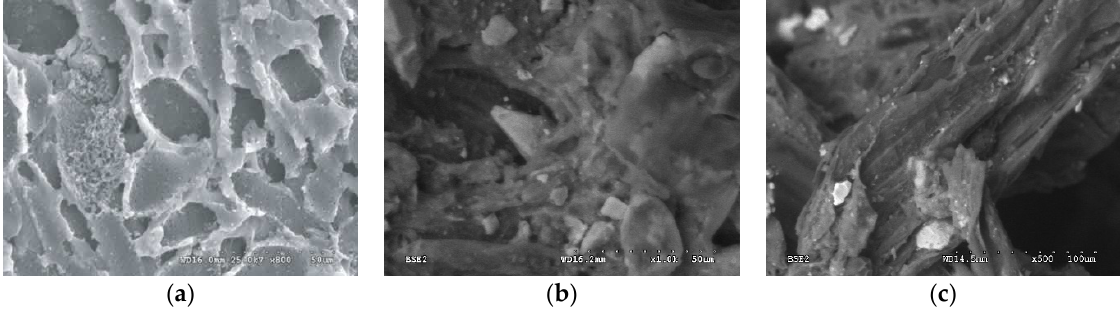
Figure 1. Scanning electron microscope (SEM) photos of NP-5 ( a ), WG-12 activated carbon ( b ), and compost ( c ).